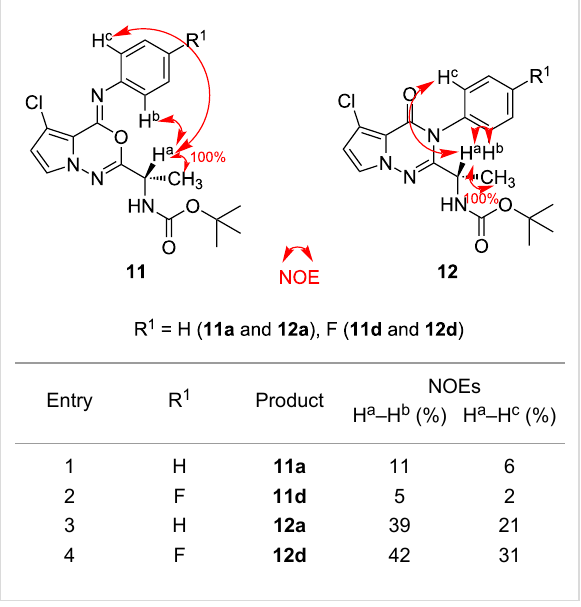
Table 4: NOE analysis of representative examples ( 11a / 11d and 12a / 12d